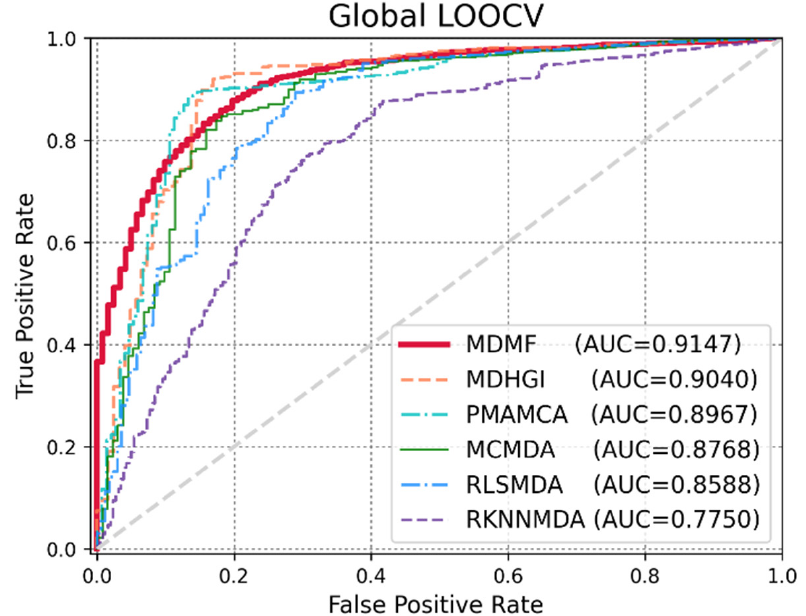
Figure 3. Performance comparisons between MDMF and five existing miRNA–disease association prediction models (MDHGI, PMAMCA, MCMDA, RLSMDA, and RKNNMDA) in terms of AUCs based on global LOOCV.